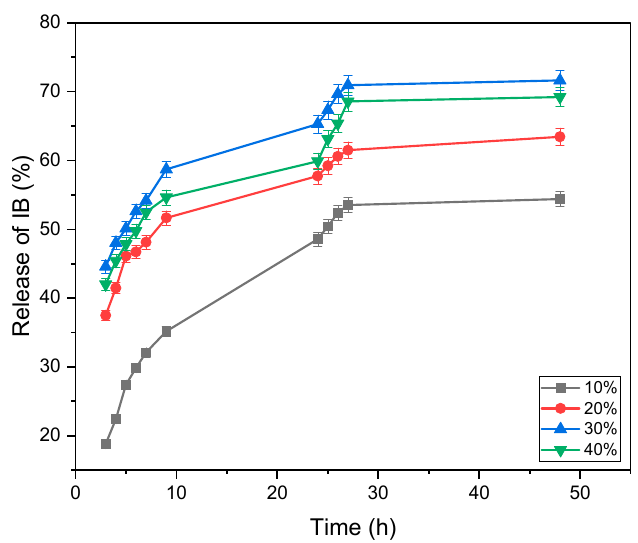
Figure 10. Evaluation of the release of various amounts of IB from the PCD-zeolite.